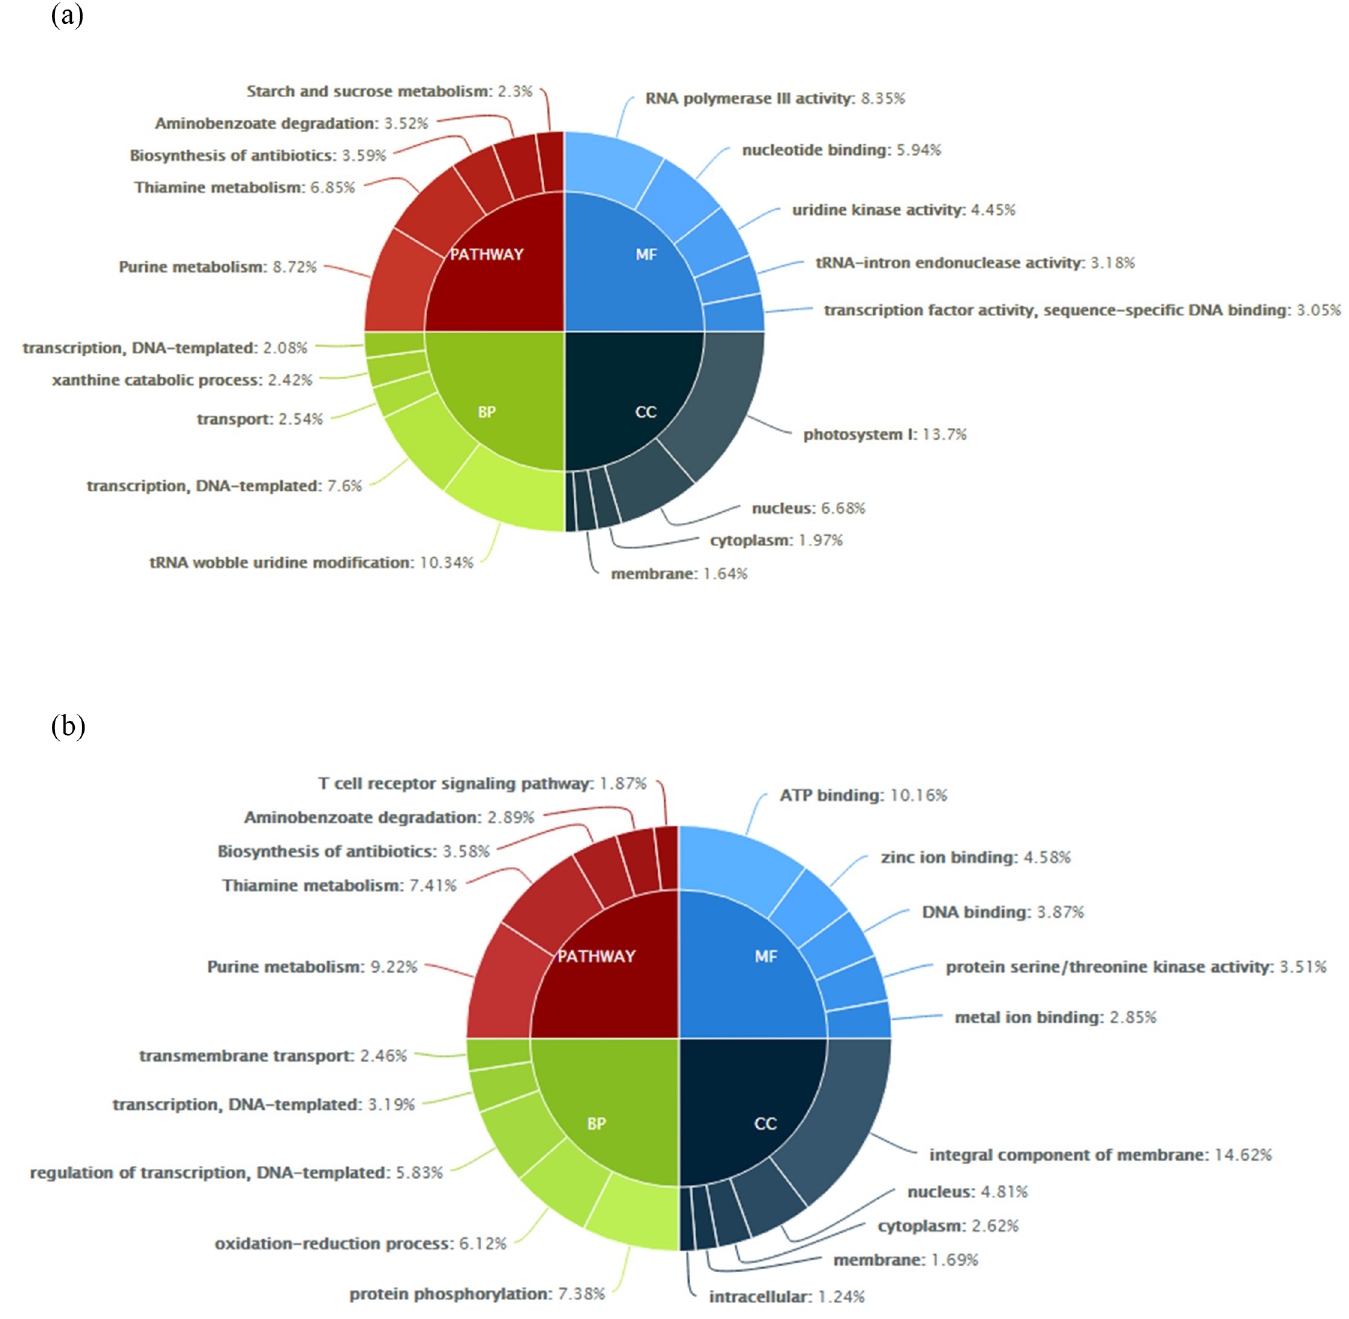
Fig 4. Classification of top five Gene Ontology (GO) categories of annotated transcripts in (a) C . cajan and (b) C . platycarpus .